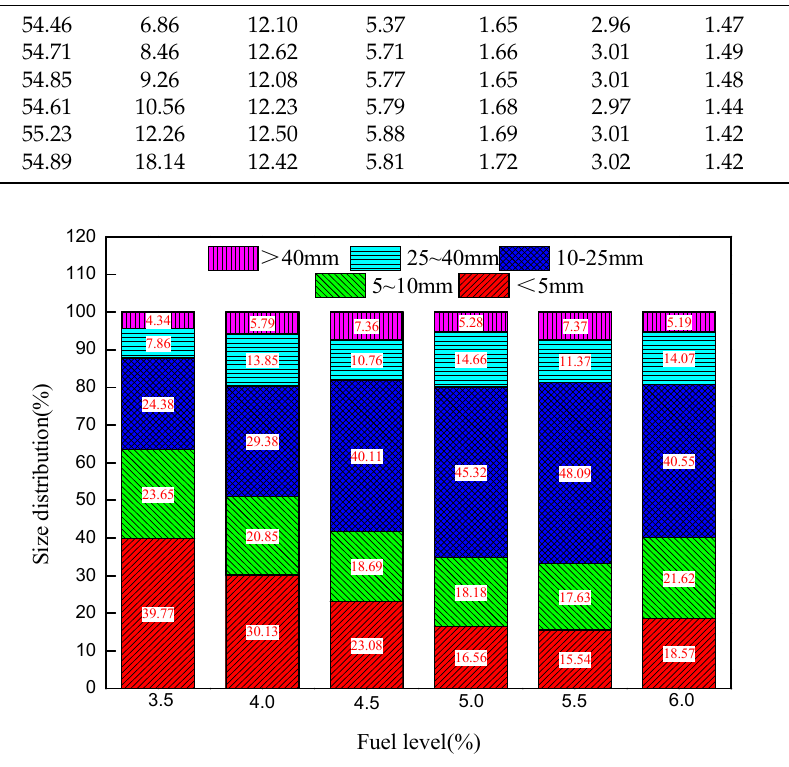
Table 4. Chemical compositions of RVT sinters (+5 mm) at different fuel levels (mass, %). Item